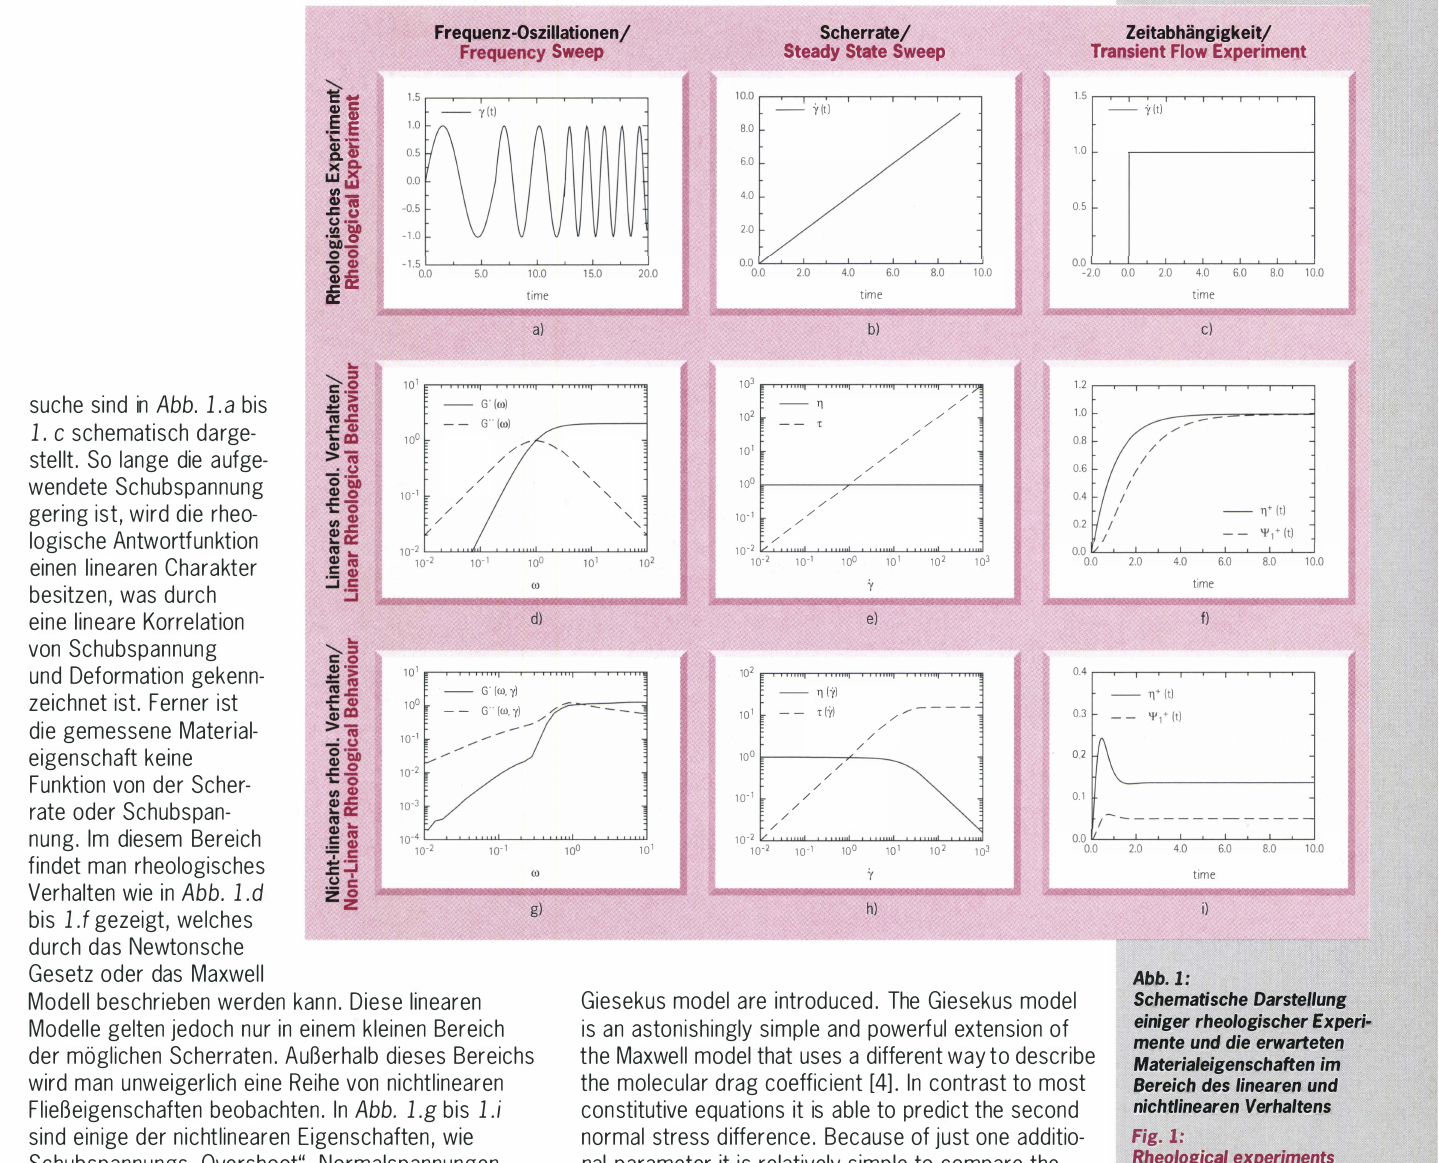
Fig. I: Rheological experiments and the correlated material functions in the regime of linear and nonlinear material